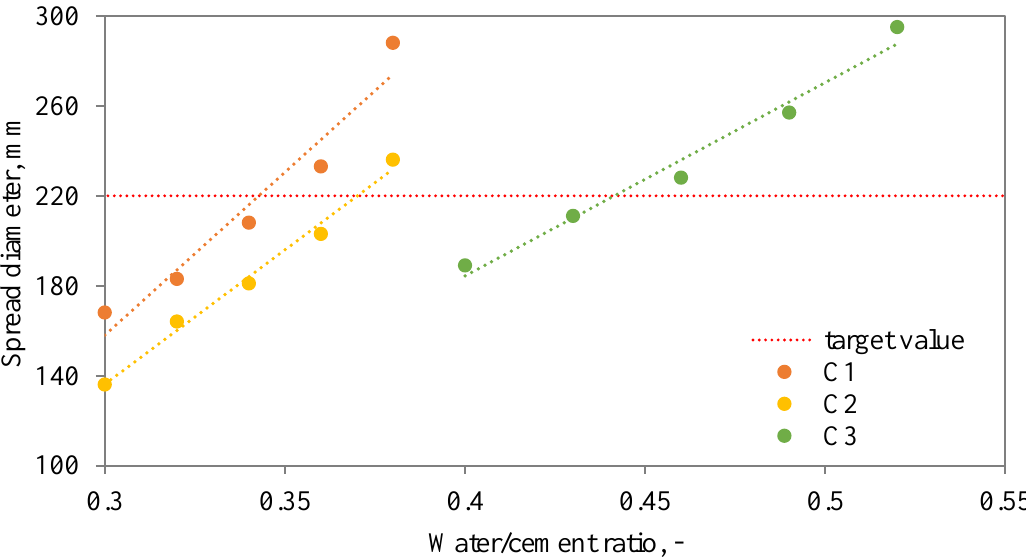
Figure 6. Dependency between spread diameter and additional water dosage for H mixtures.